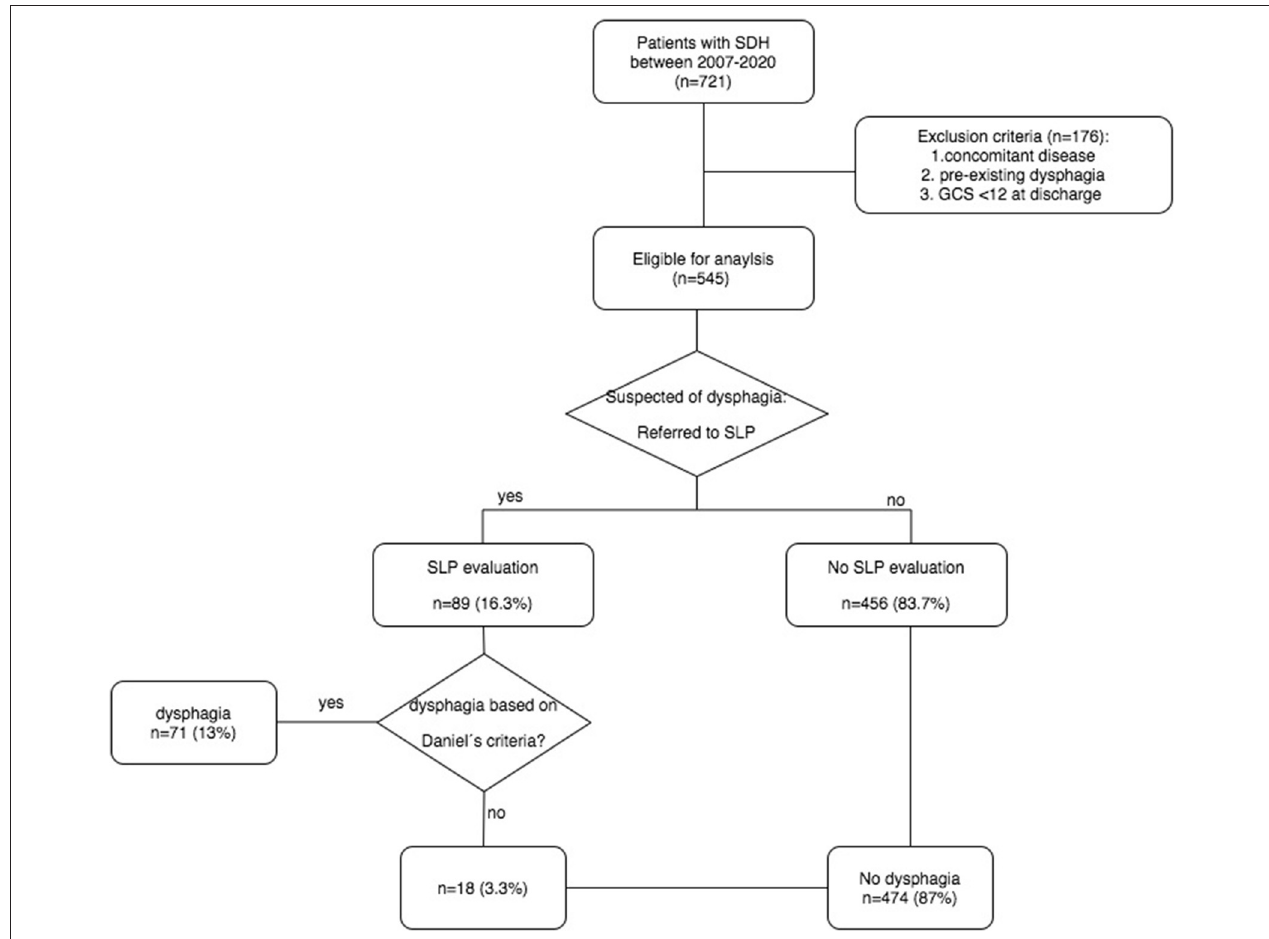
FIGURE 1 | Flow-chart of dysphagia screening. SDH, subdural hematoma; GCS, Glasgow Coma Scale; SLP,